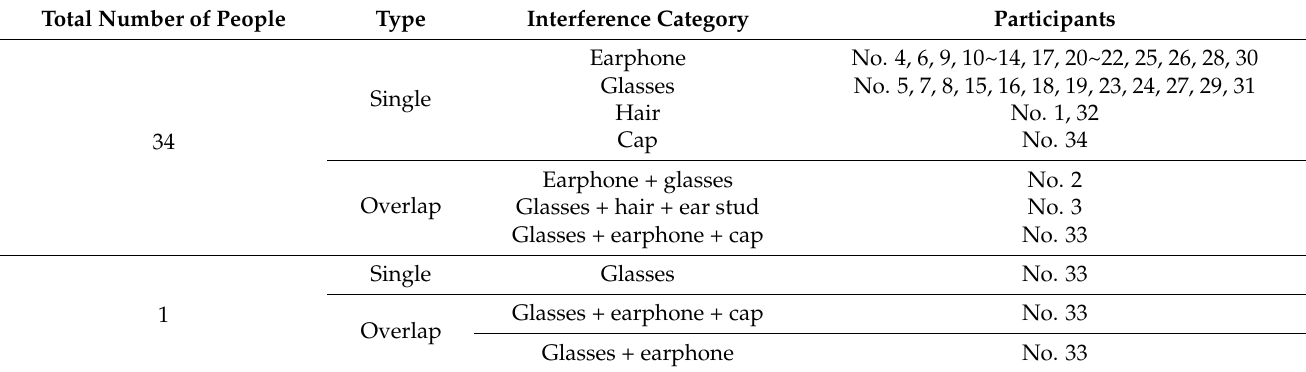
Table 8. Interference information of Eardata5.